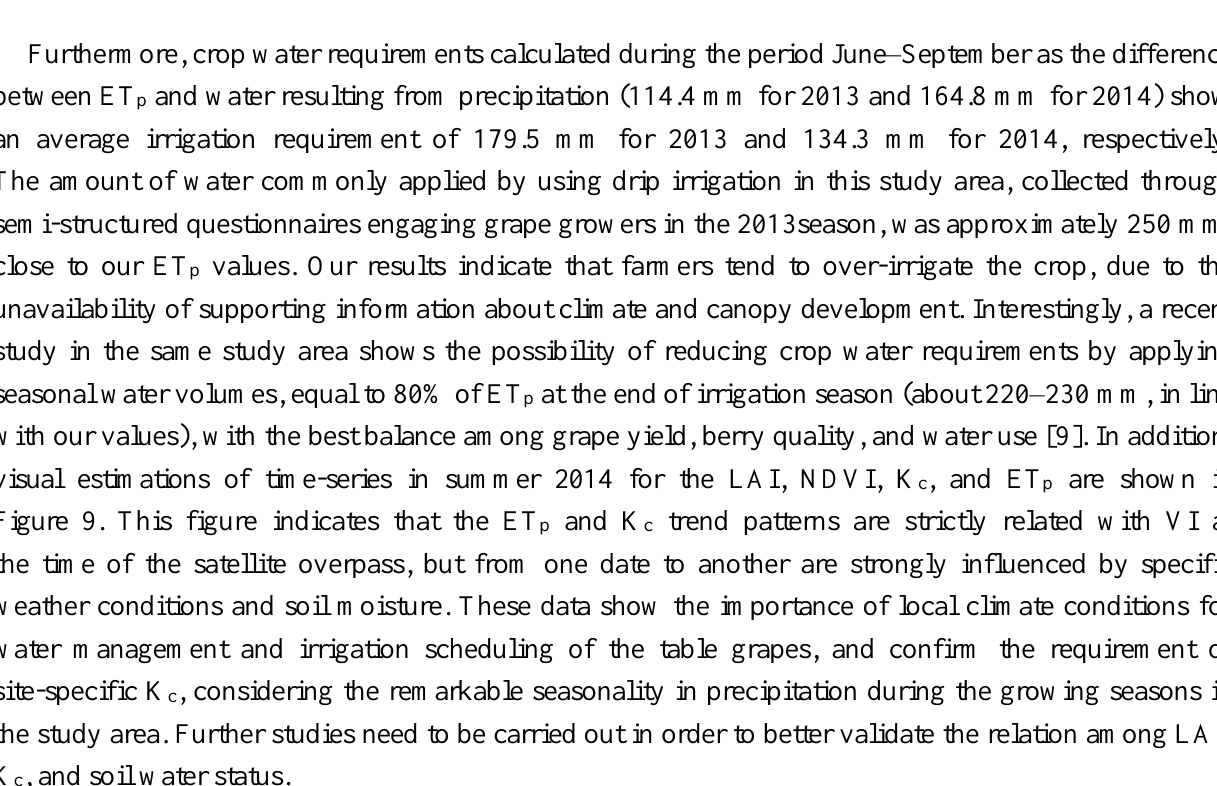
Figure 8. Cumulative values and trend line evolution of